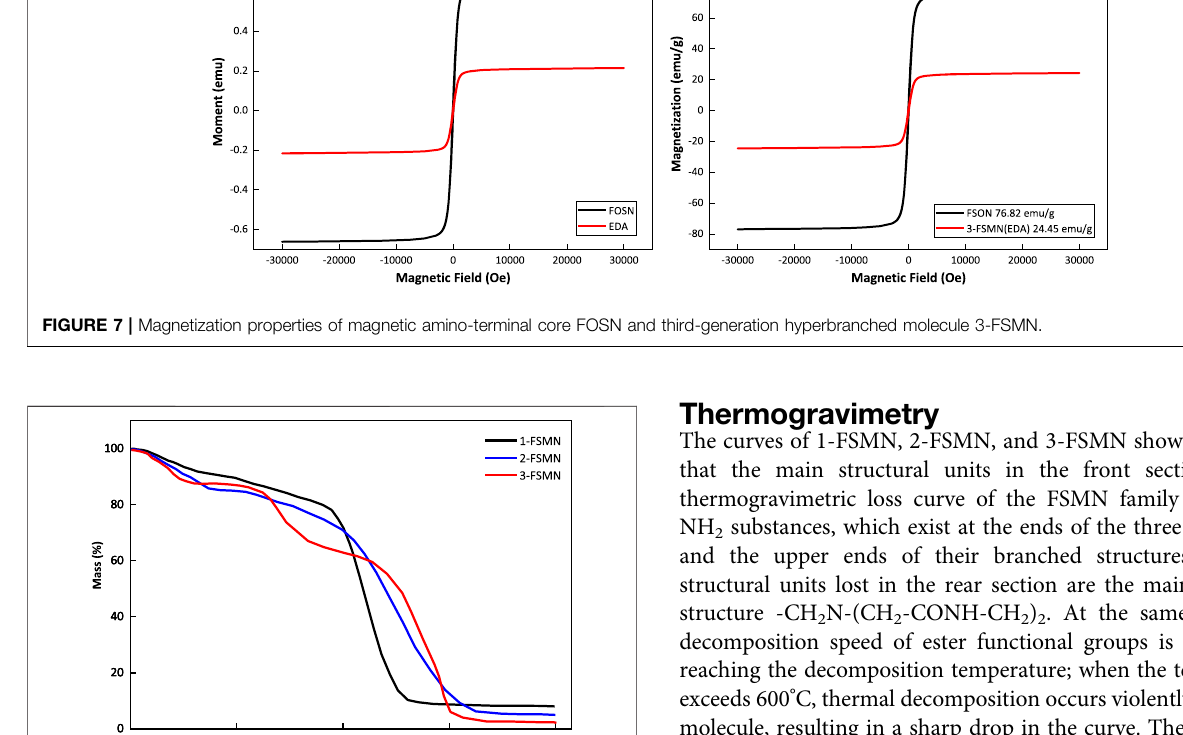
Frontiers in Chemistry |